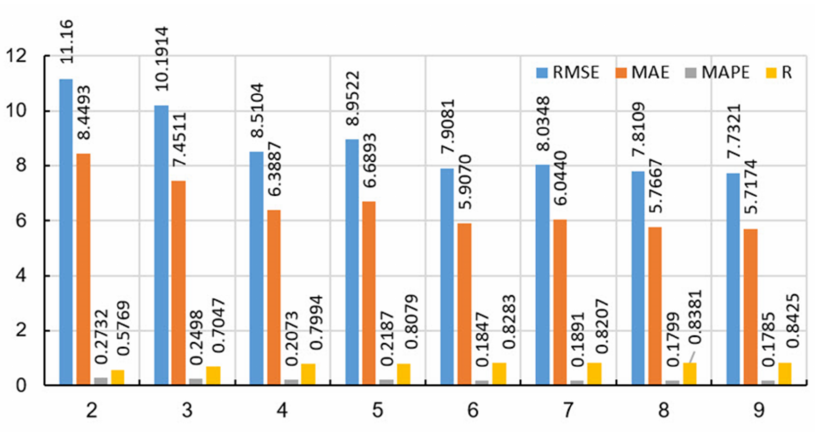
Figure 14. Influence of the number of variables on which is performed splitting on the accuracy of the model in the RF